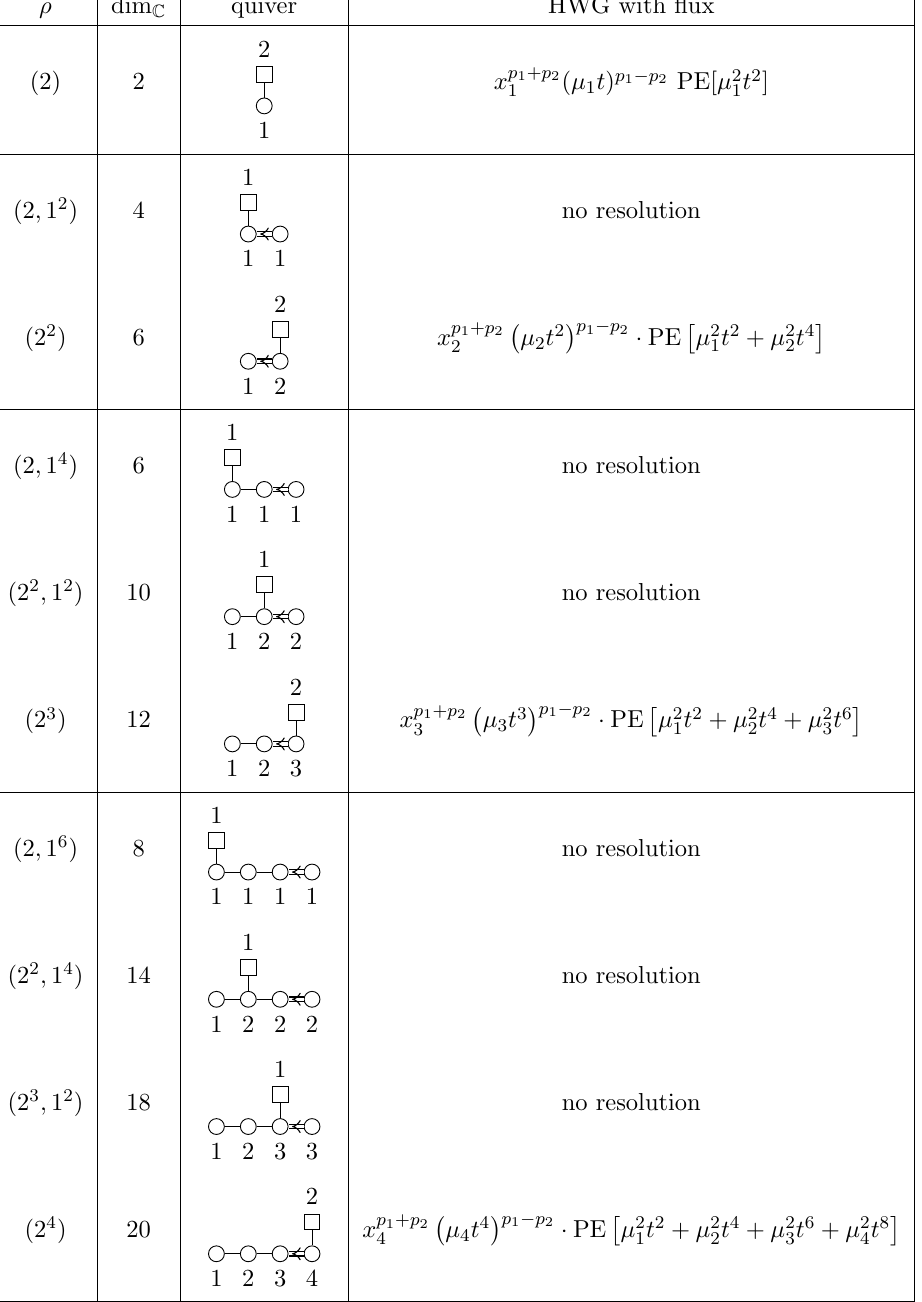
Table 5 . Coulomb branch quiver gauge theories for C -type algebras: realisations of the (closures of the) nilpotent orbits of height 2 for C n , for n = 1 ; 2 ; 3 ; 4. To eliminate the unphysical U(1) in G F in the HWG, one proceeds as before: introducing an auxiliary fugacity z 0 for U(1) (cid:26) G F , and P j p j imposing z